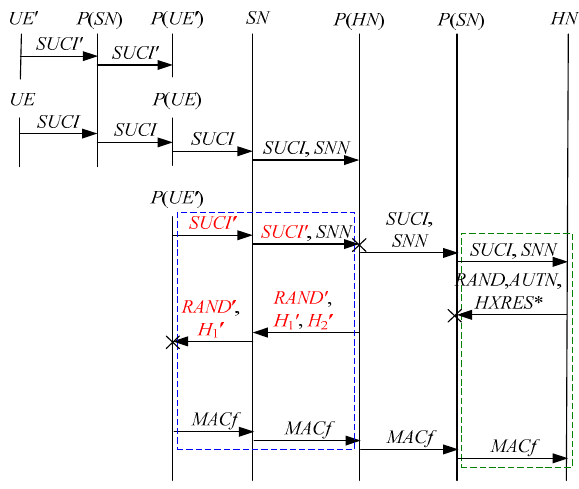
Figure 14. The thirteenth attack scenario of the 5G AKA protocol. In Figure 14, the green dashed box represents the server strand of Theorem 6, while the blue dashed box represents the responder strand of Theorem 6. The fields marked in red on the responder strand are some fields that cannot be agreed with the HN, which are caused by MitM attacks.